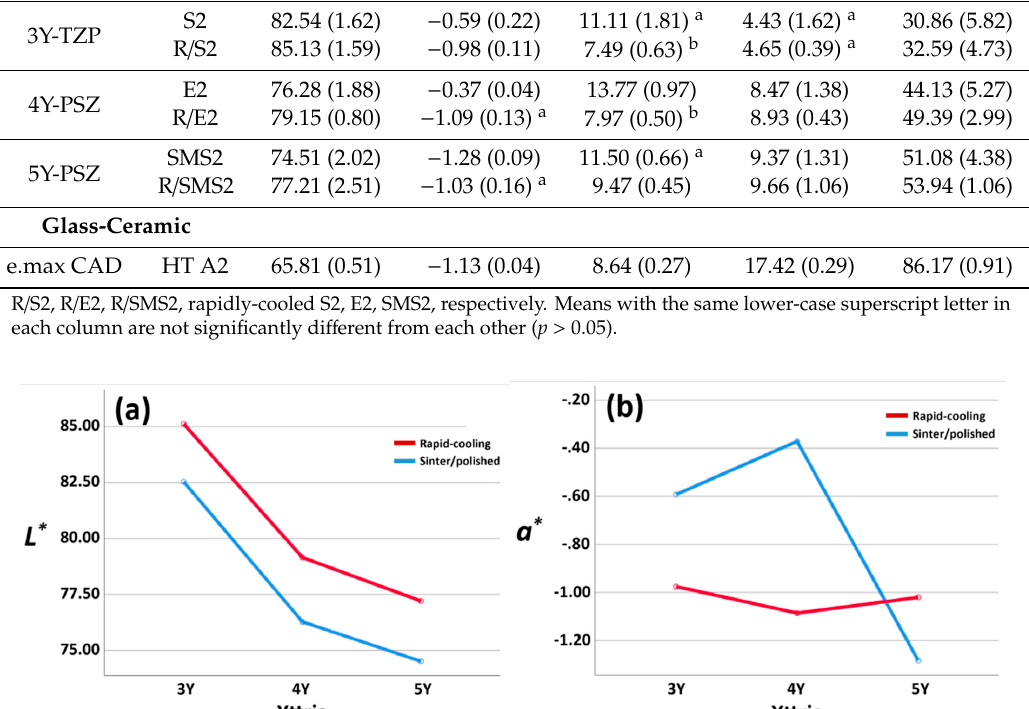
Table 2. Means (standard deviation) of CIE L * , a * , and b * against an A2 background, TP, and T% at 550 nm of each group.